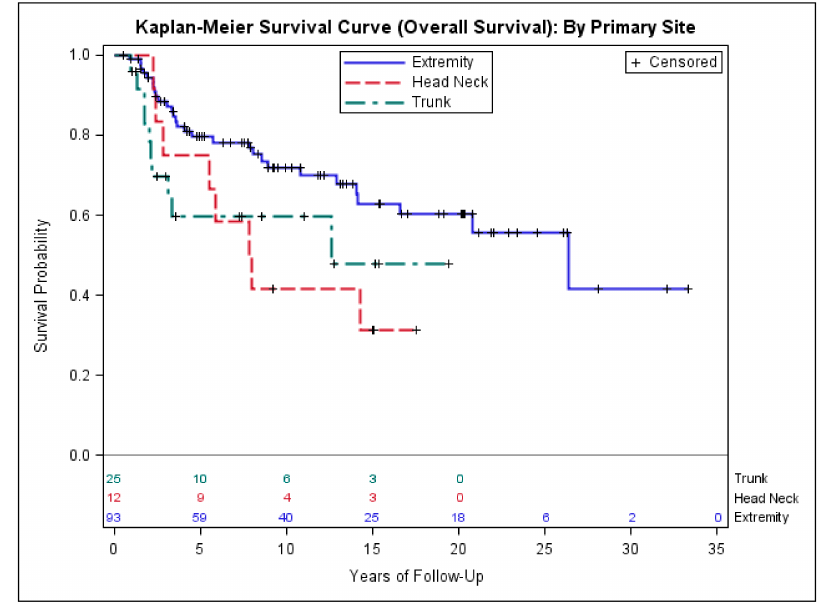
Figure 2. Kaplan–Meier estimates of overall survival of early-stage patients with extremity, head and neck, and trunk